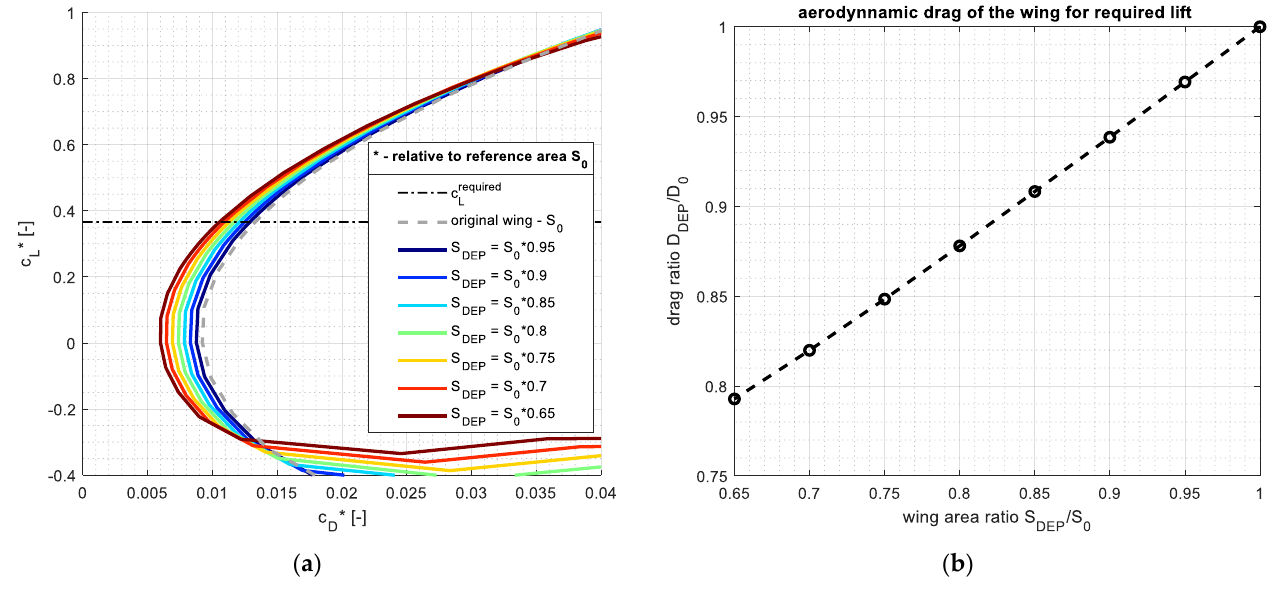
Figure 8. Aerodynamic characteristics of different wing areas; ( a ) aerodynamic polar, lift, and drag coefficients relative to the original wing area (dashed line) and required lift in the cruise regime (dash dotted line); aerodynamic drag relative to the drag of the original wing as a function of the wing area ratio ( b ).